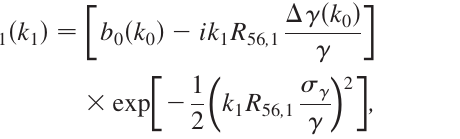
TABLE II. BC1 and DC parameters for compression provided